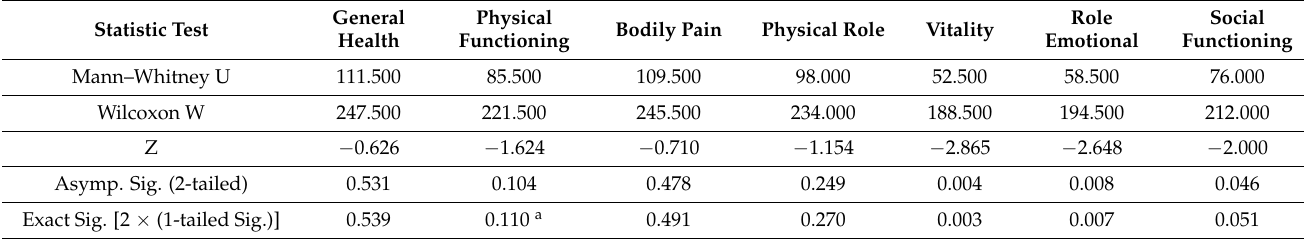
Table 4. Quality of life, short form-36, subscales RSWT versus UST lots—Mann–Whitney and Wilcoxon